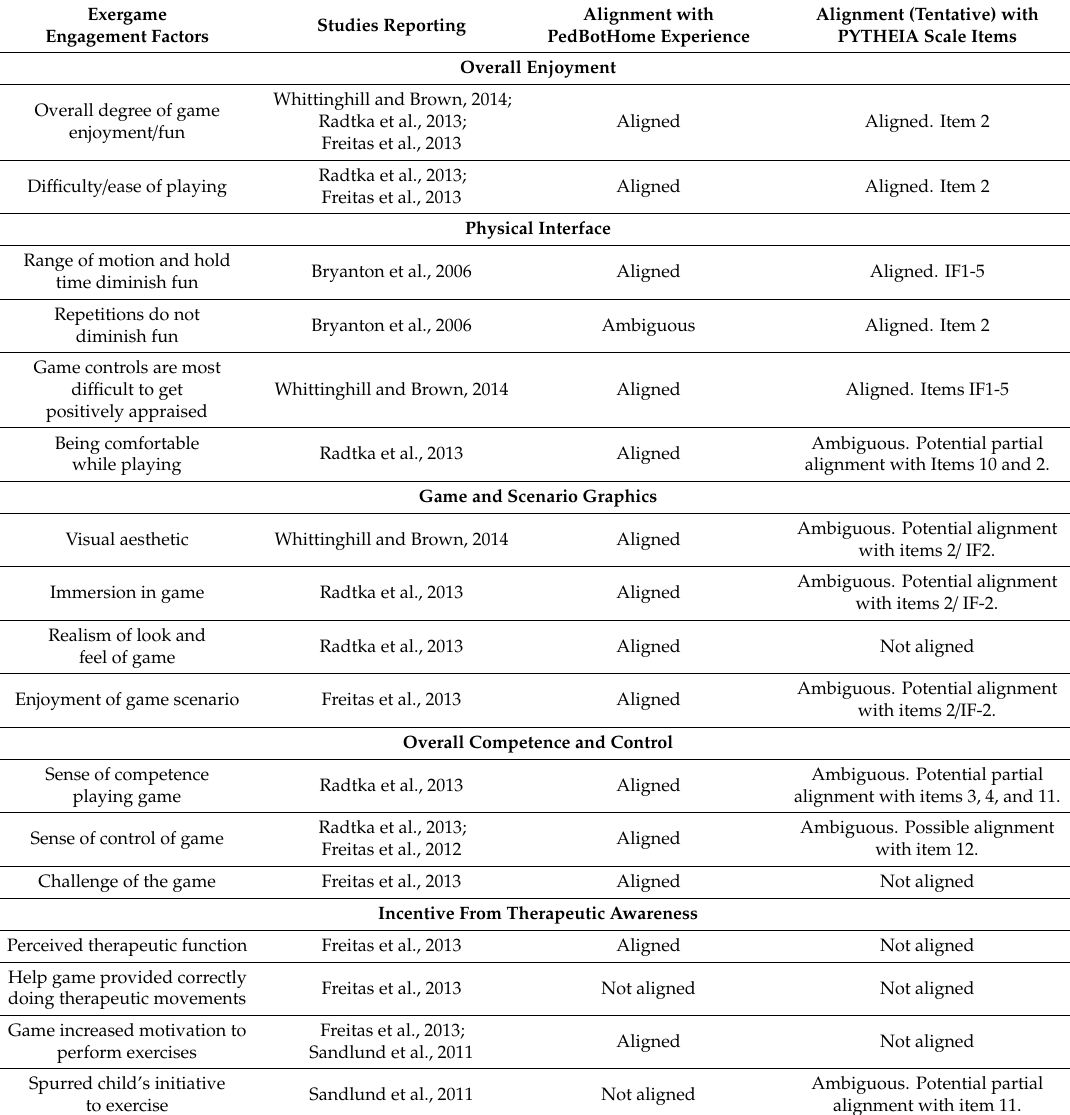
Table 5. Exergame Engagement Factors Alignment with PedBotHome Experience and PYTHEIA [31] Scale